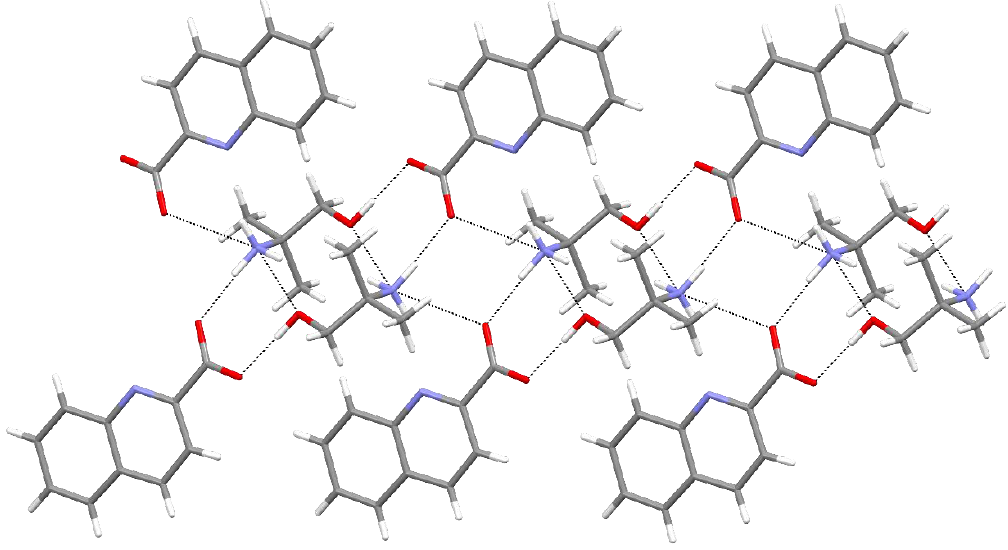
Figure 6. Section of a chain in 3b